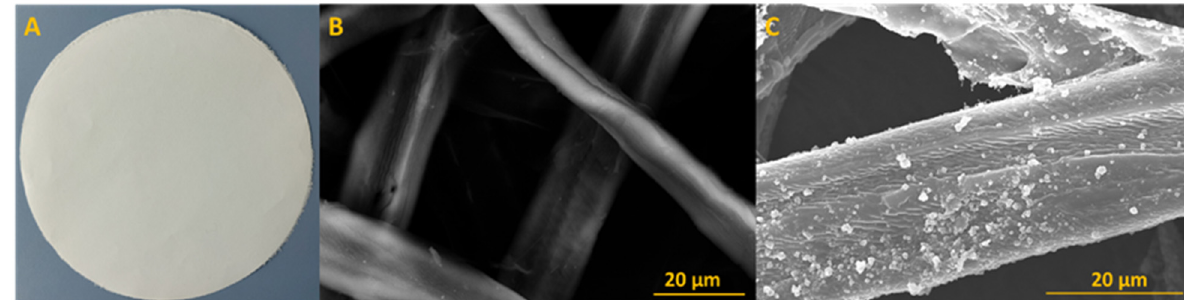
Figure 2. ( a ) Obtained paper disk form Rapid apparatus and ( b ) Scanning Electron Microscope image of reference paper sheet and ( c ) paper sheet with TiO 2 8%.